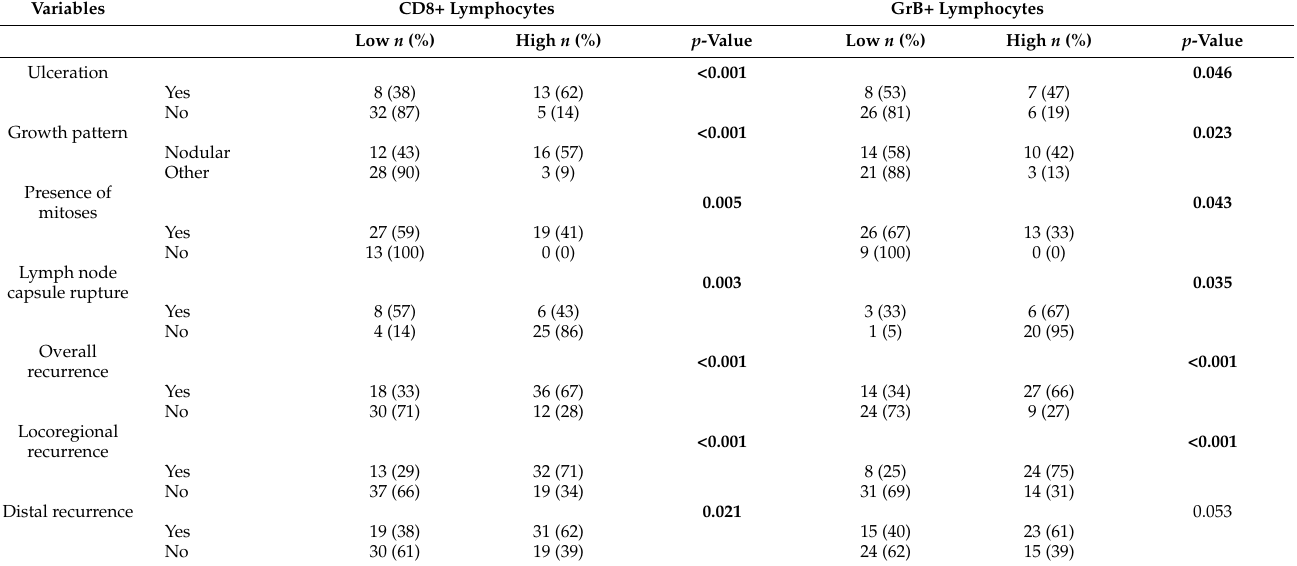
Table 5. Various associations of CD8+ and GrB+ lymphocytes with clinicopathological